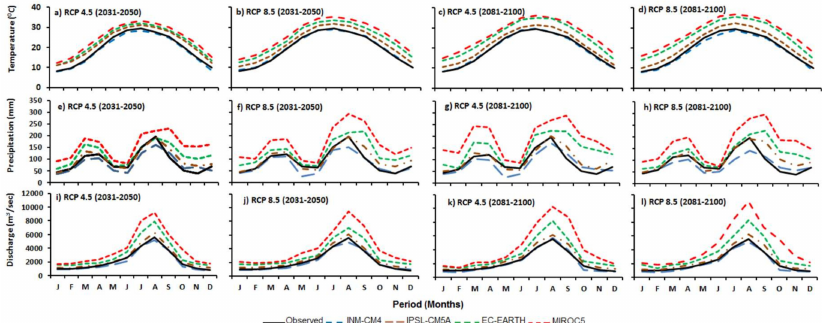
Figure 6. Variation in average monthly temperature ( a – d ), average monthly precipitation ( e – h ) and average monthly flow ( i – l ), all based on 20 years data for the Kabul river basin. When comparing observational data (1981–2000) and downscaled scenario data from four selected General Circulation Models (GCMs) under two Representative Concentration Pathways (RCPs) 4.5 and 8.5 in near (2031–2050, ( a , b , e , f , i , j )) and far future (2081–2100, ( c , d , g , h , k , l